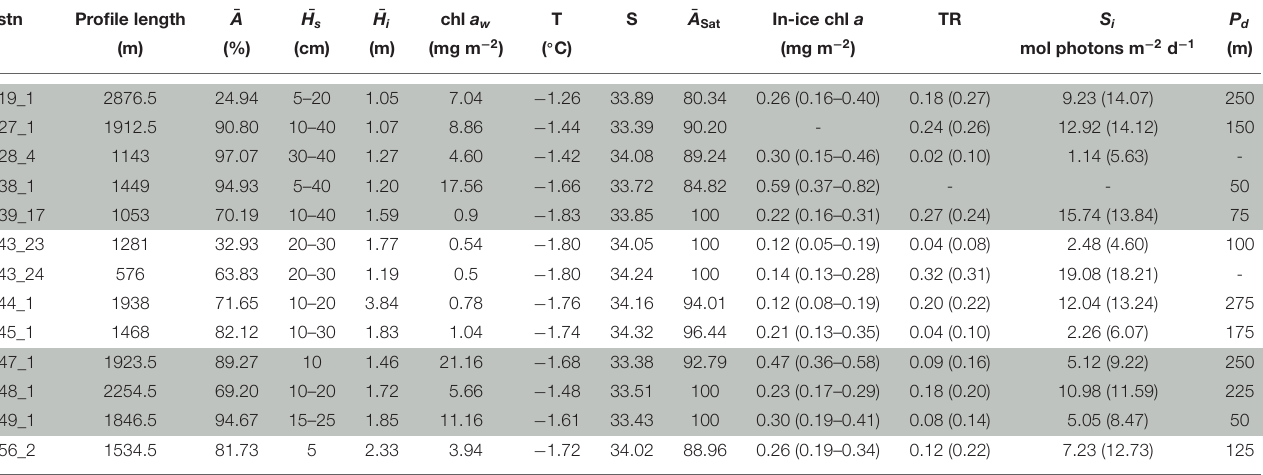
TABLE 3 | Table for PS92 with, for each station (stn), the total profile length, the mean ice concentration ( ¯ A ) along profile, mean snow depth ( ¯ H s ) and mean total ice thickness ( ¯ H i ), under-ice water chl a (chl a w ) multiplied by the vertical section of the SUIT (2m) to obtain integrated values, under-ice water temperature and salinity, ice concentration retrieved from satellite ( ¯ A Sat ), median in-ice chl a (interquartile range), mean transmittance TR ( ± one standard deviation), mean Insolation S i ( ± one standard deviation), and the draft patch size ( P d ).